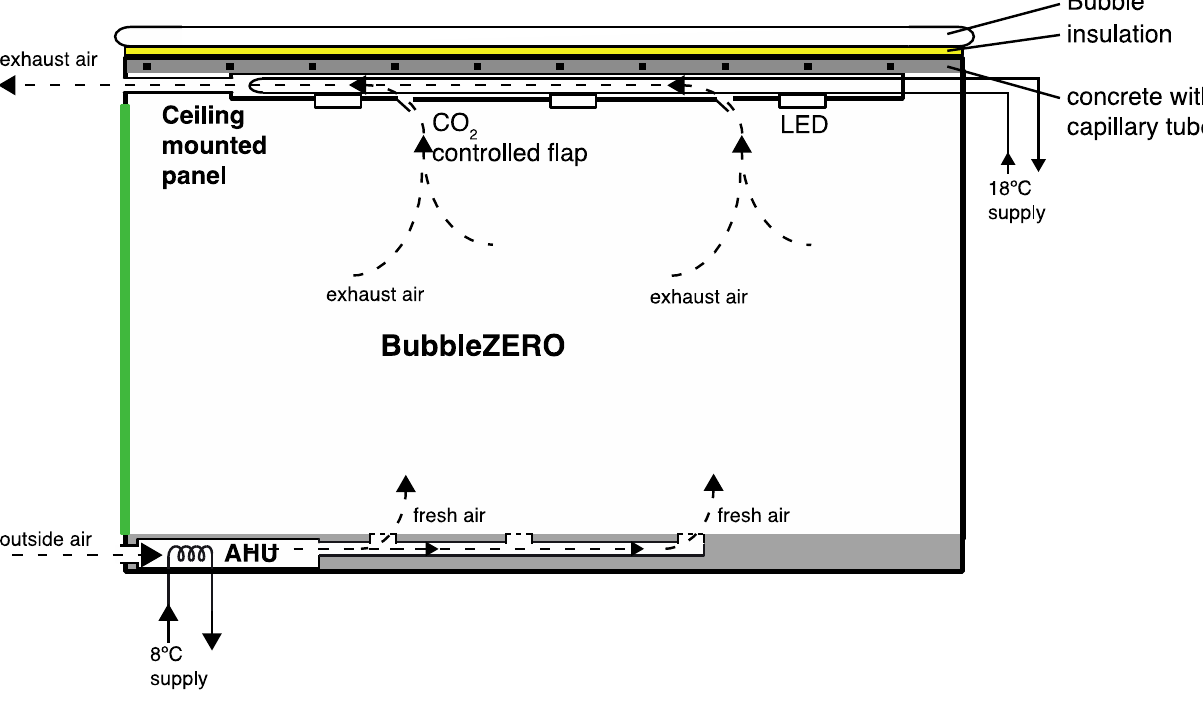
Figure 4. Schematic section of the cooling and ventilation systems of the